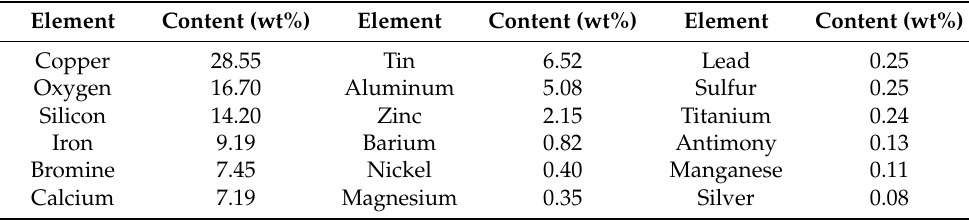
Table 1. The element composition of PCB sample.